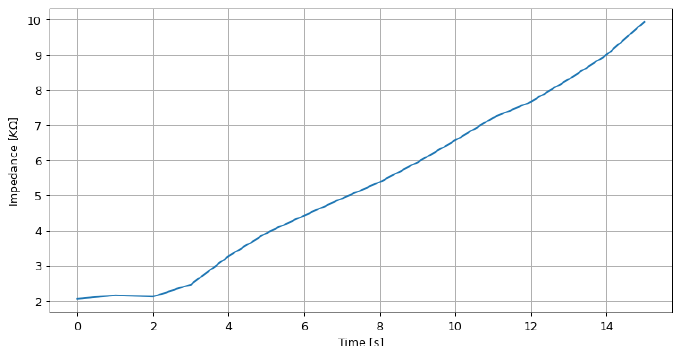
Figure 9. Real-time impedance measurement results by varying a 10 KOhm potentiometer.